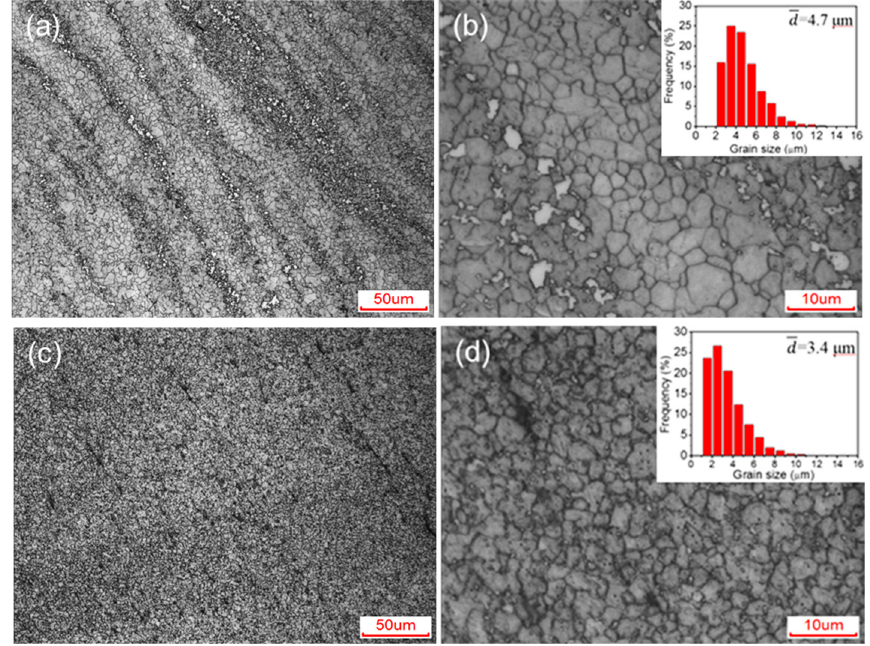
Figure 3. Optical micrographs of ( a,b ) C ‐ ECAP and ( c,d ) H ‐ ECAP AZ91 alloys in ( a,c ) low ‐ magnification and ( b,d ) high ‐ magnification.